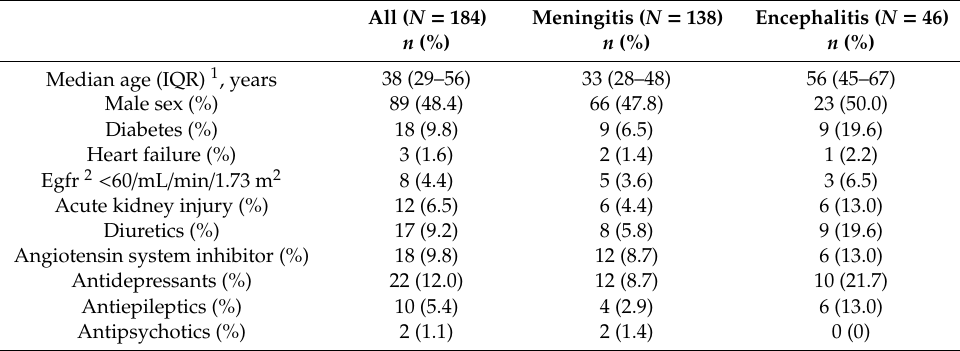
Table A1. Patient characteristics and use of medications by clinical